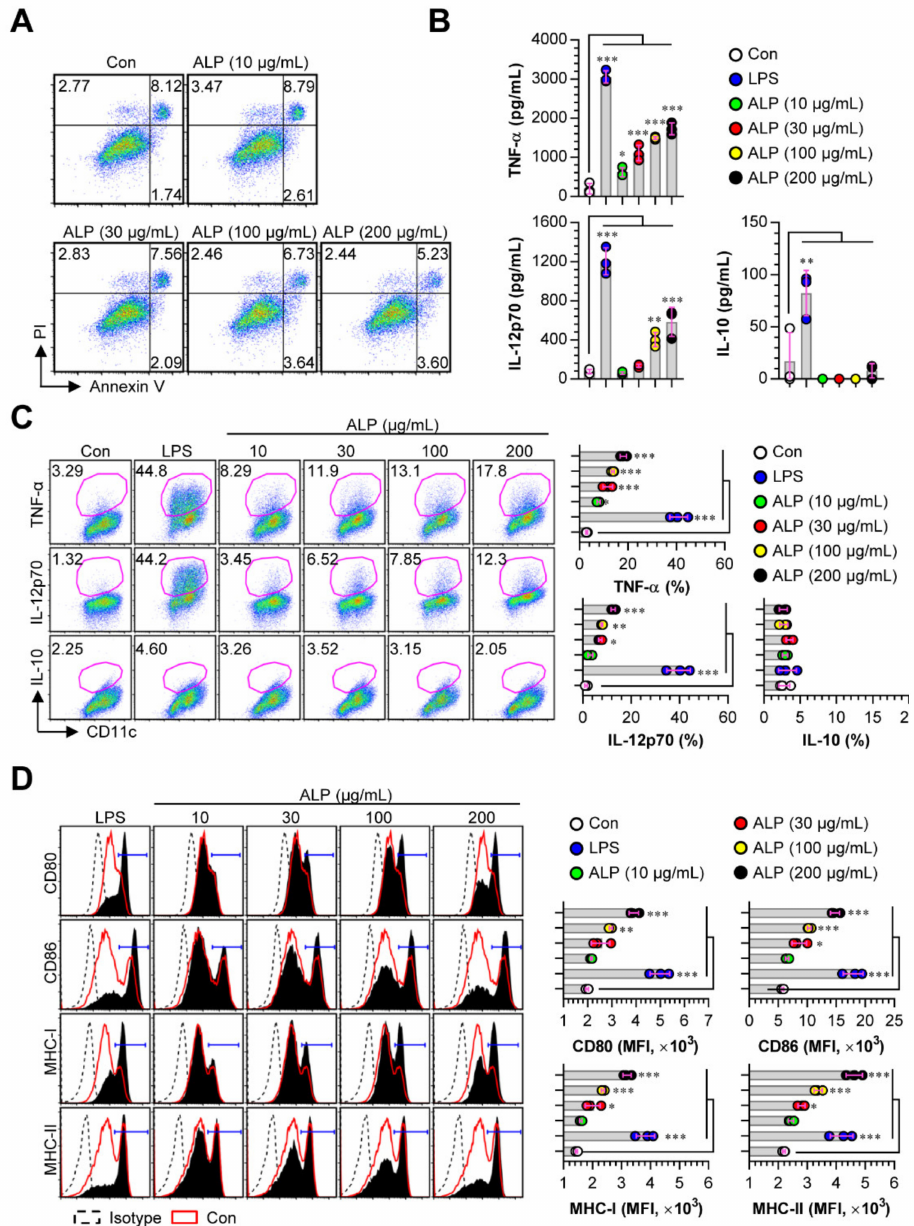
Figure 1. Cytotoxic activity, surface molecule expression, and cytokine production in ALP-stimulated dendritic cells (DCs). DCs were treated with A. muricata L. leaf polysaccharide (ALP) (10, 30, 100, and 200 µ g / mL) and LPS (100 ng / mL) for 24 h. ( A ) Cell toxicity was determined using AnnexinV / PI staining (PI + cells; necrosis, AnnexinV + PI + cells; early necrosis, AnnexinV + cells; apoptosis). ( B ) The culture supernatant was used to analyze the production of TNF- α , IL-12p70, and IL-10 using ELISA. ( C ) Intracellular cytokine levels of pro- (TNF- α and IL-12p70) and anti-inflammatory cytokines (IL-10) were assessed in non-, LPS-, and ALP-treated DCs. ( D ) Expression levels of CD80, CD86, MHC-I, and MHC-II in CD11c + -gated cells were detected by FACS. The mean fluorescence intensities of surface molecules in CD11c + cells are shown in each panel. These results are indicated as the mean ± SD ( n = 3 samples) of 3 representative experiments. * p < 0.05, ** p < 0.01, or *** p < 0.001. SD; standard